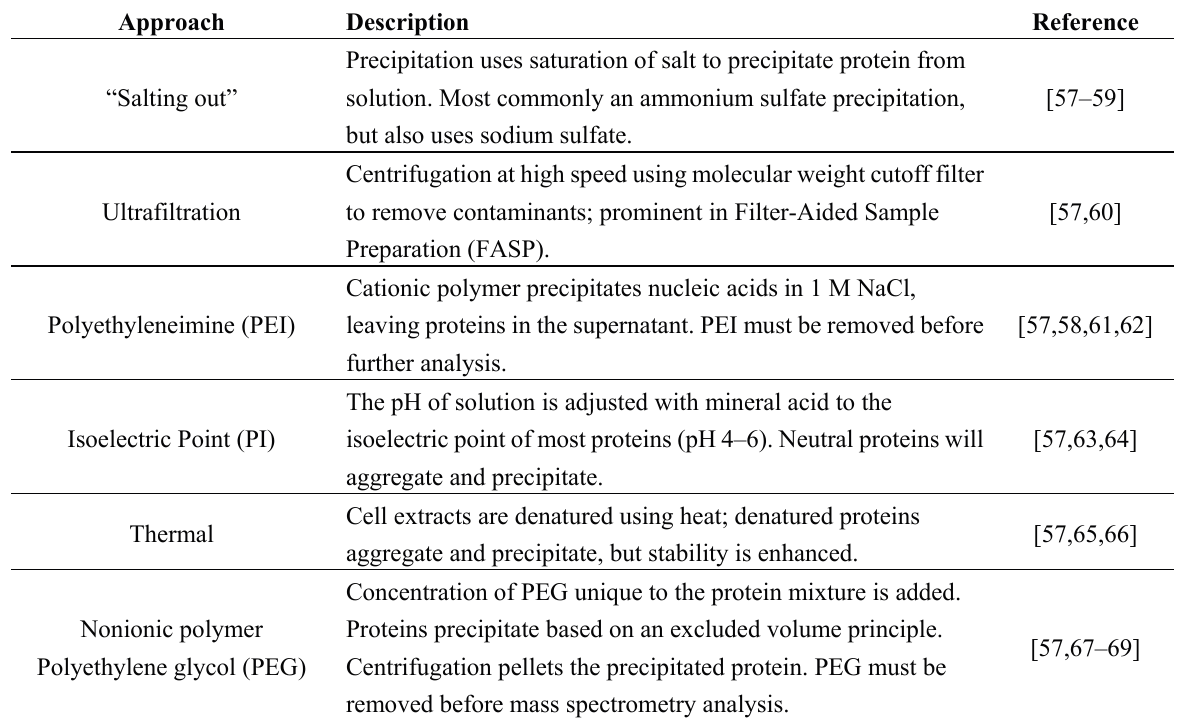
Table 2. Approaches for contaminant and detergent removal in proteomic